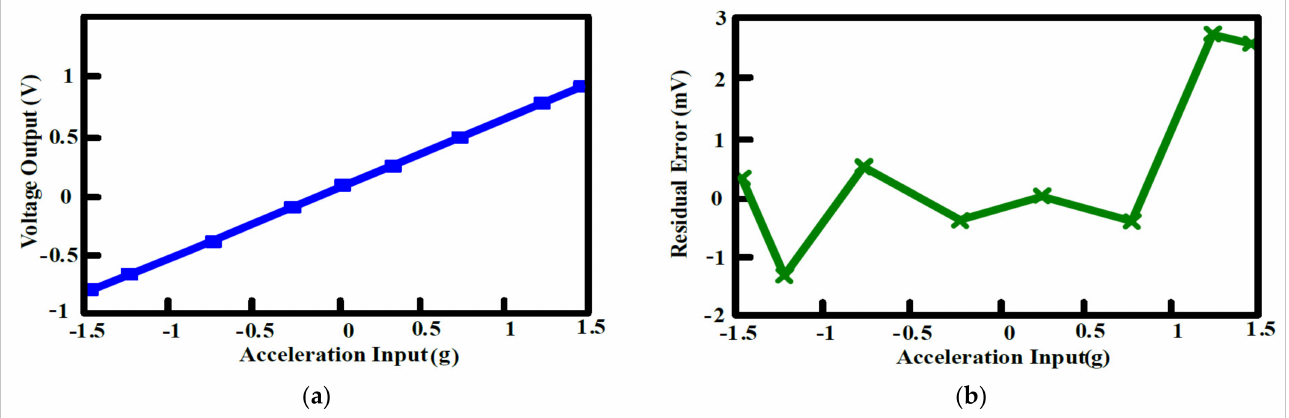
Figure 16. DC acceleration sweep measured ( a ) Voltage output versus acceleration input; ( b ) residual